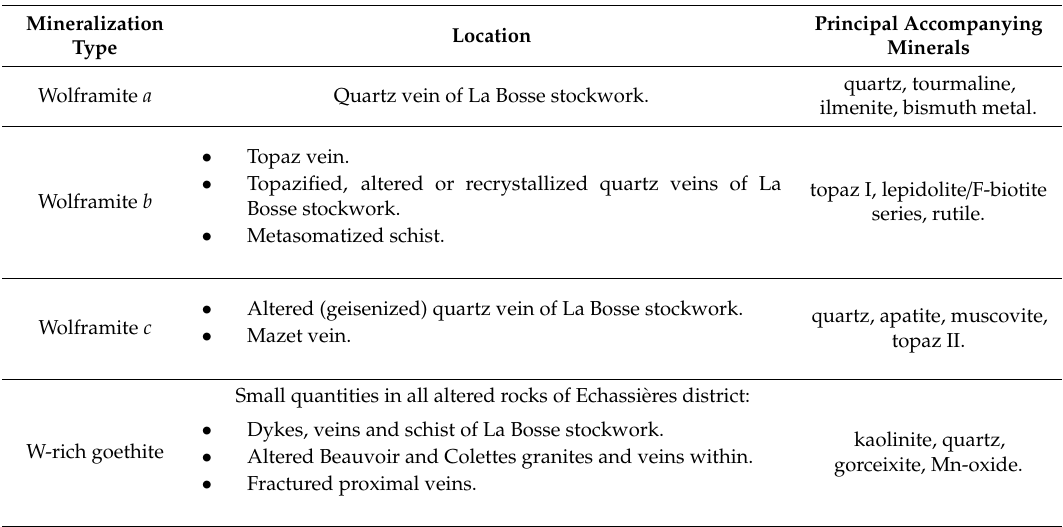
Table 2. Distribution of the di ff erent types of wolframite and of late W-rich goethite in the Echassi è res